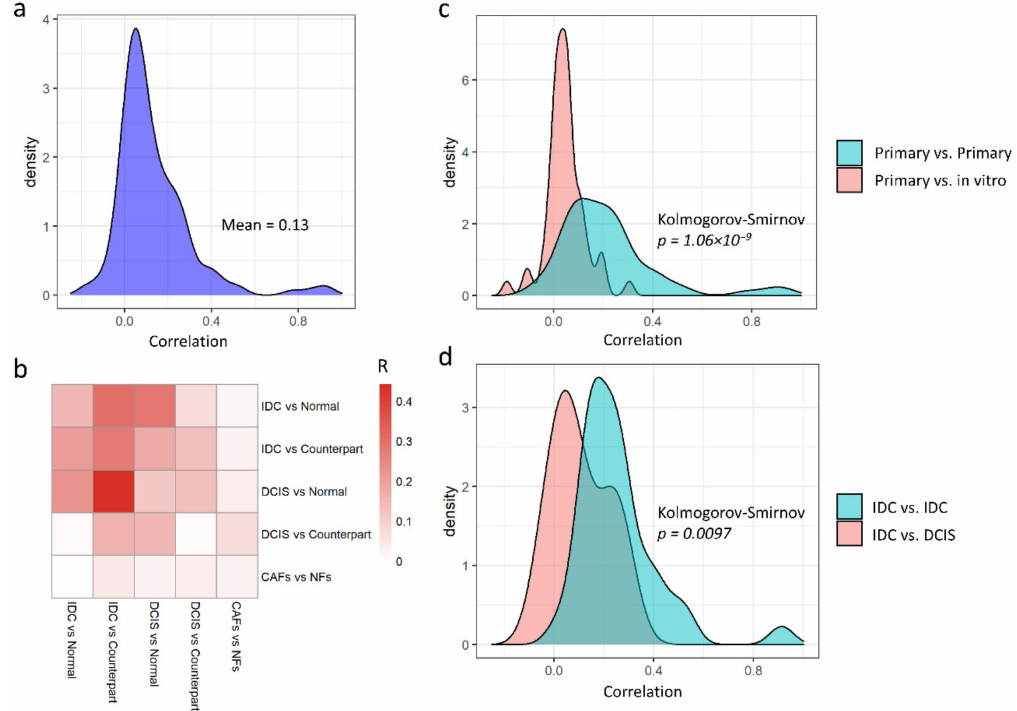
Figure 1. Similarity between stroma datasets of detected genes changing between normal and cancer samples. ( a ) Distribution of Pearson’s correlation between log2 fold changes (logFC) of genes between cancerous/non-cancerous con- ditions in each dataset, showing an average correlation of 0.13. All datasets comprising both cancerous and non-cancerous stromal samples were used, and pairwise correlations between datasets are shown. ( b ) Correlation of logFC between groups of datasets comparing invasive ductal carcinoma (IDC) and normal breast tissue from healthy donors (normal) or histologically normal tissue adjacent to tumor (counterpart), cuctal carcinoma in situ (DCIS) vs. normal or counterpart, cancer associated fibroblasts (CAFs) and normal fibroblasts (NFs) grown in vitro. Red indicates a high average positive correlation. ( c ) Distribution of Pearson’s correlations between logFC obtained from datasets sampling primary tumors or comparing logFC obtained from primary tumors or from in vitro experiments. ( d ) Distribution of Pearson’s correlations between logFC obtained from datasets sampling IDCs or comparing logFC obtained from IDCs and from DCIS.